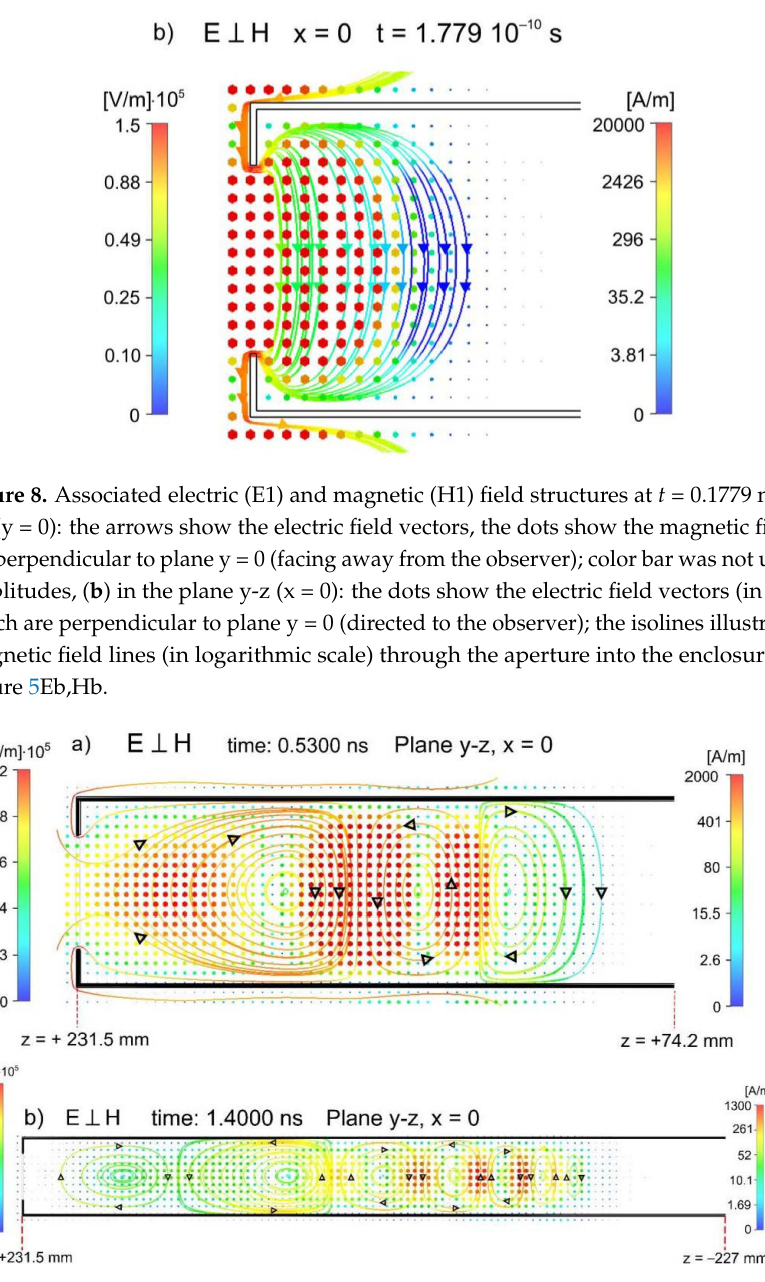
Figure 9. Associated electric and magnetic field structures in the plane y-z (x = 0): ( a ) at t = 0.530 ns (structures E4 and H4) and ( b ) at t = 1.400 ns. The dots show the electric field vectors, the isolines show the magnetic field lines (in logarithmic scale) in the enclosure. Retrieved from Figure